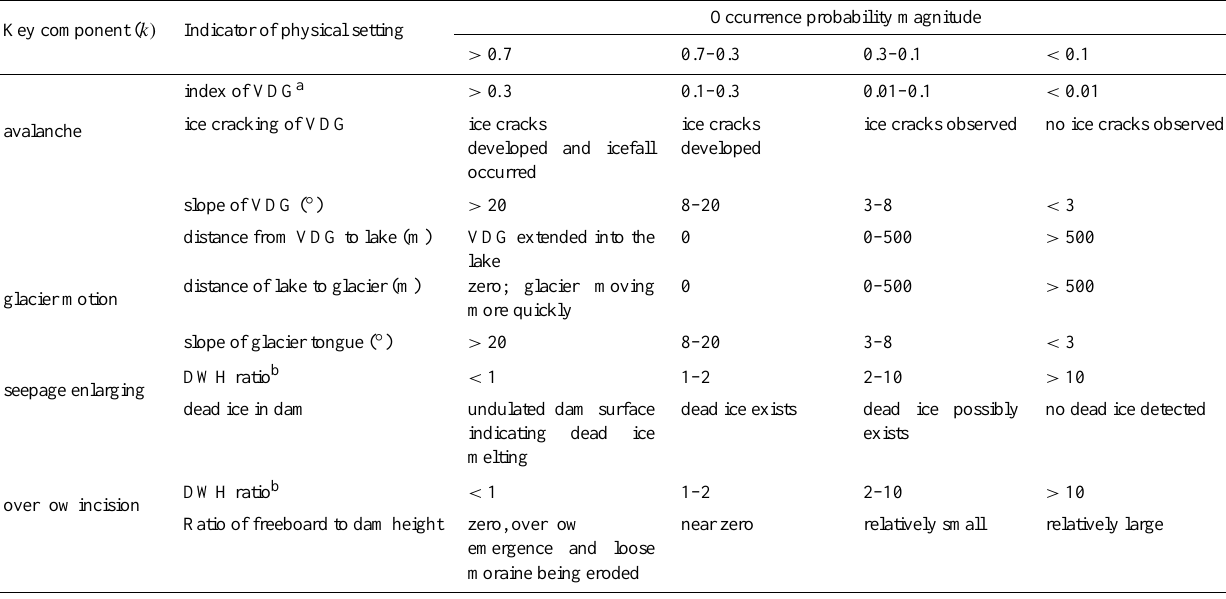
Table 5. Guidelines for quantifying the occurrence probabilities of key components of precursory developments on the basis of physical characteristics of the parent glacier, dam and lake basin of documented MDLOF events on the Tibetan